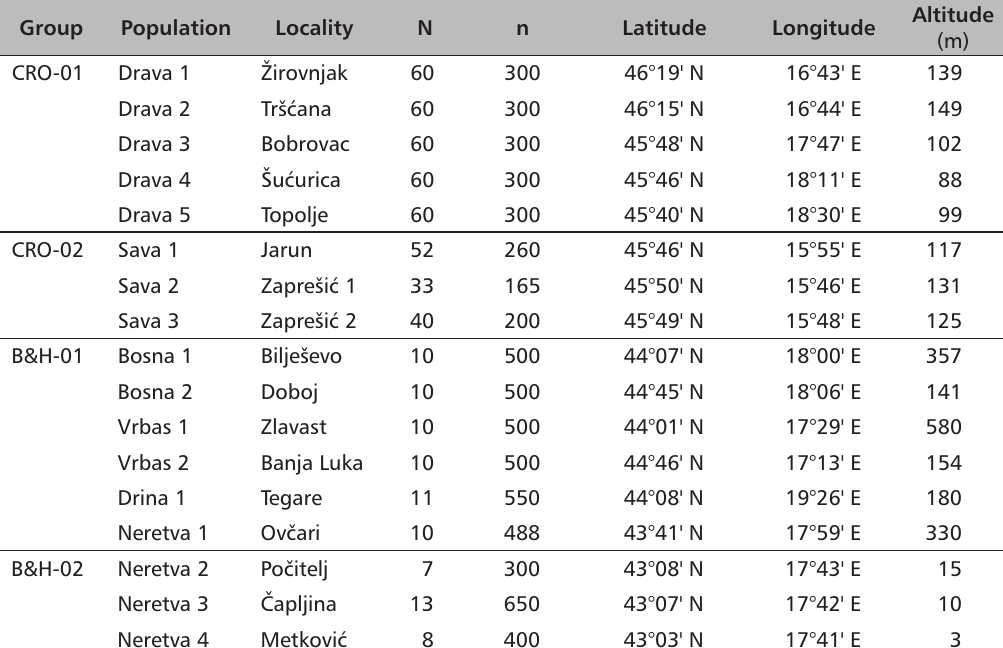
N - number of sampled trees; n - number of sampled leaves